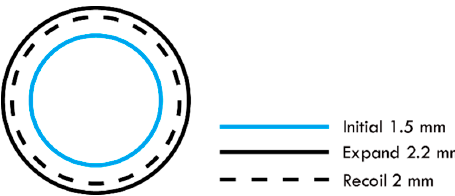
Figure 7. The cross-sectional view of the cylindrical stent for simulating the expansion process, including the initial state, the expansion due to the balloon, and the radial force exerted by the blood vessel.